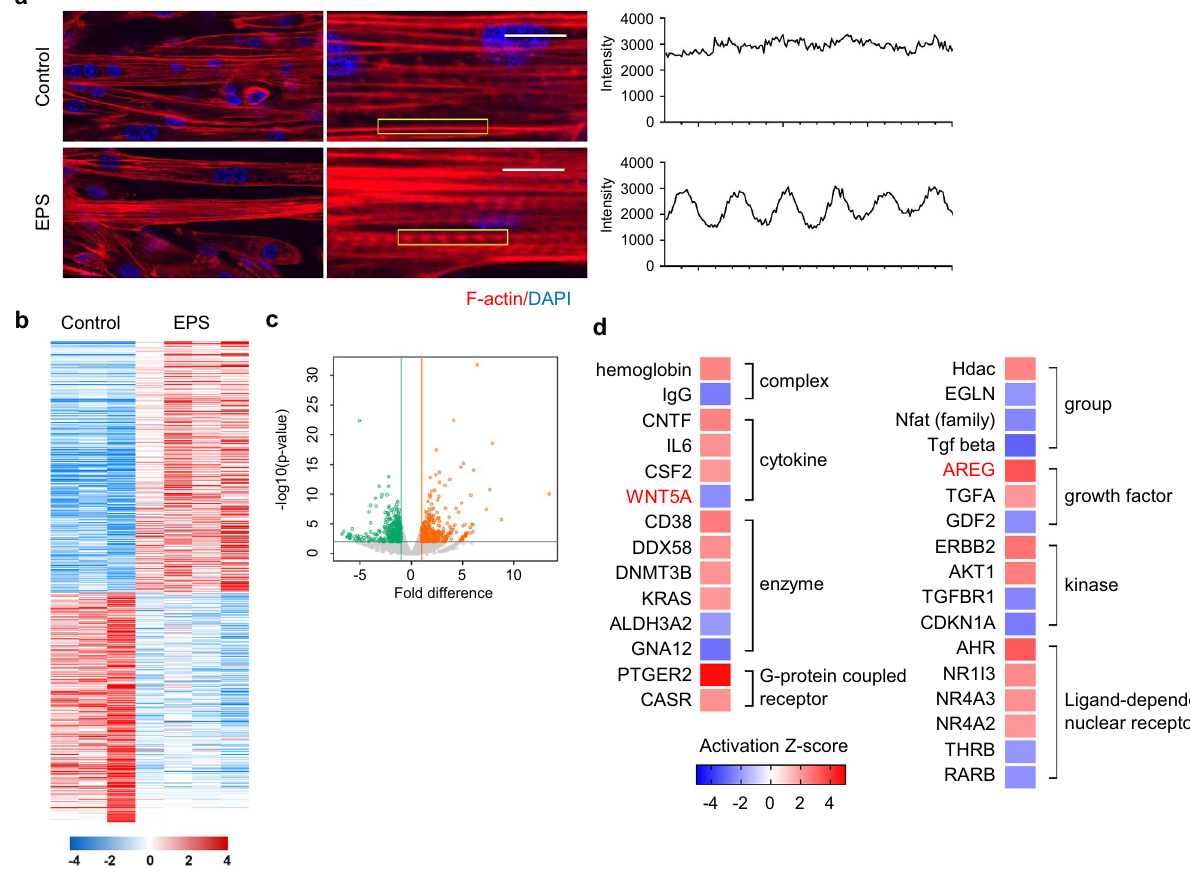
Figure 1. Effect of EPS in C2C12 myotubes. ( a ) ( Left ) Confocal images of C2C12 myotubes after applying EPS for 24 h, stained for F-actin (red) and DAPI (blue). Yellow bracket, portion used for intensity measurement ( right ). Scale bars, 10 μm. ( b , c ) DEGs between the control (n = 3) and EPS (n = 4) groups and volcano plot of DEGs. A total of 774 DEGs was identified ( P < 0.01, fold change > 2). ( d ) Predicted upstream regulators from IPA with activation Z-scores ≥ 2 or ≤ − 2 and P <